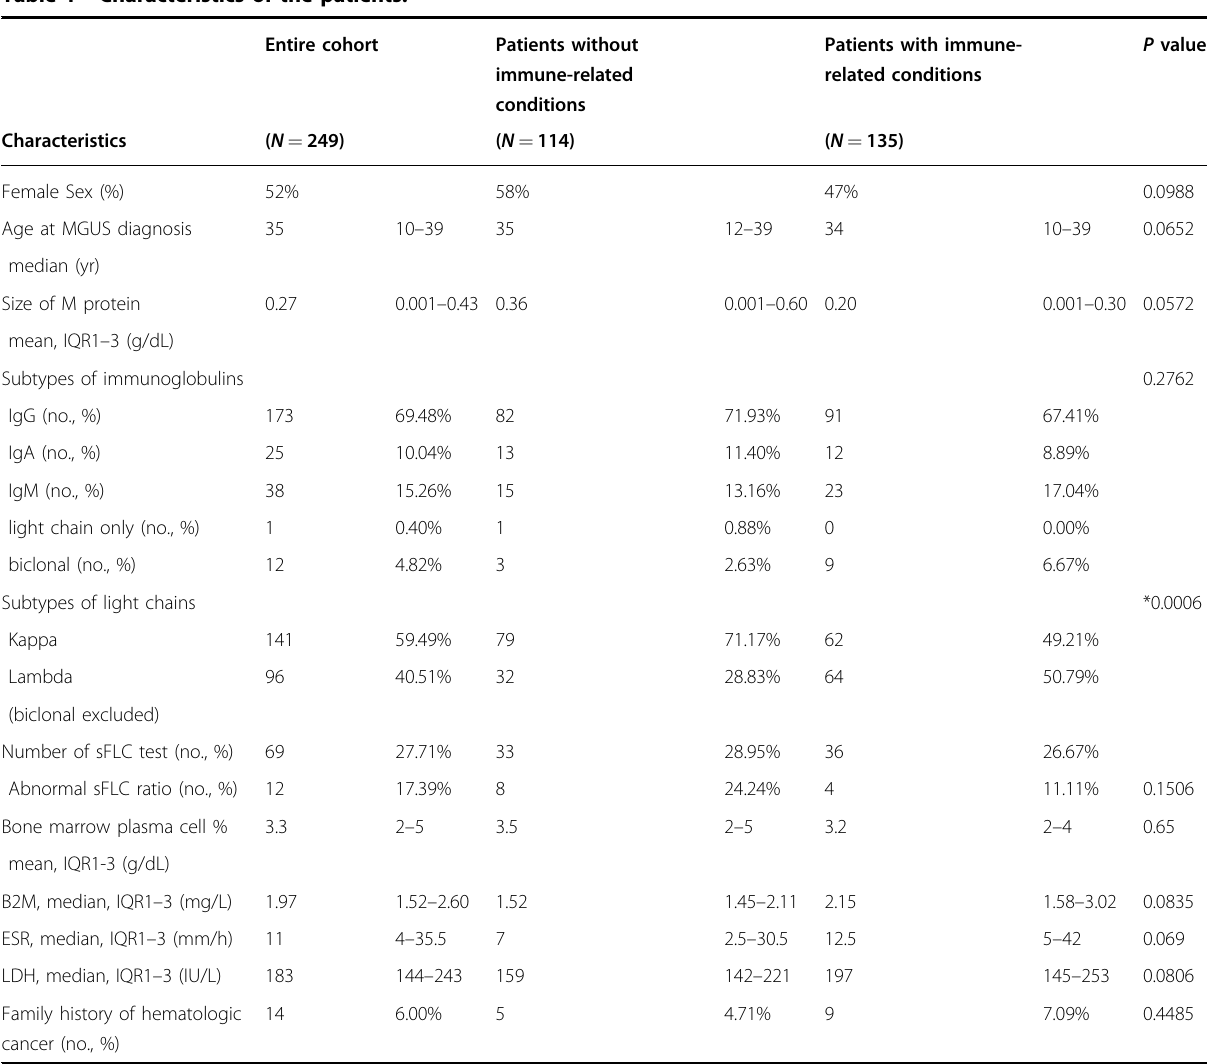
Table 1 Characteristics of the patients.